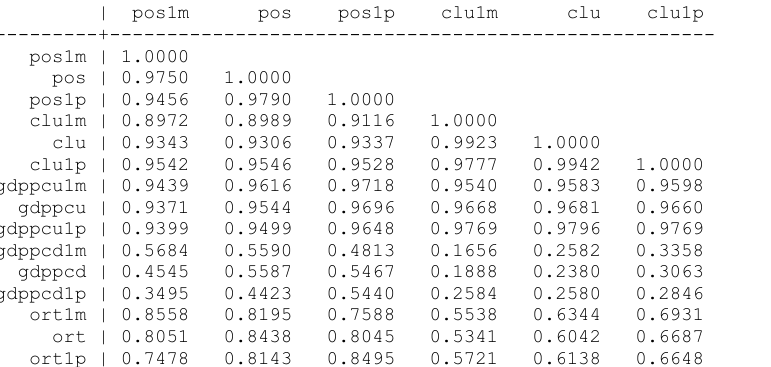
Figure 7. Cross-correlation matrix of parameters pos, clu, gdppcu, gdppcd, and ort with a 1-year shift for the entire study